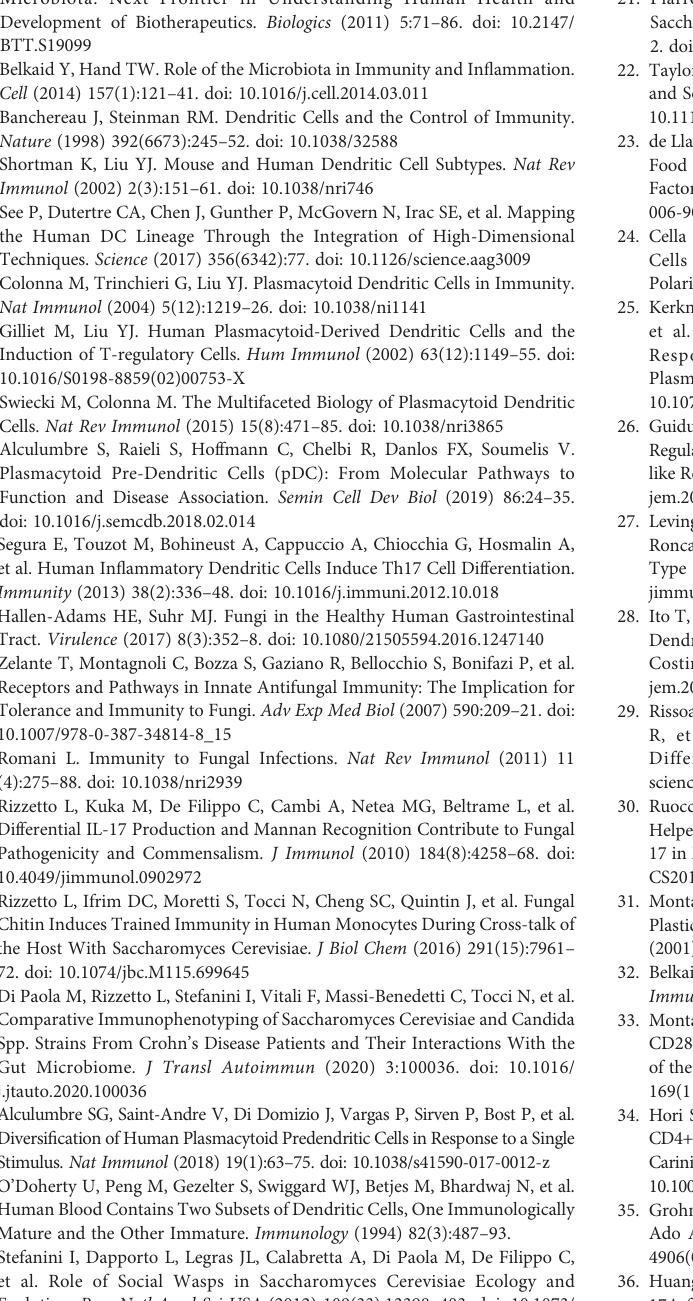
isolated from the blood of healthy donors were extracted from Affymetrix data (Human Genome U133 Plus 2.0 arrays) (48). The dashed line is the threshold of signal detection. White bars represent the mRNA levels of the receptors expressed on pDCs; gray bars indicate that the receptors were not detectable. The data are the mean of seven independent experiments, each from different donors. The error bars represent standard